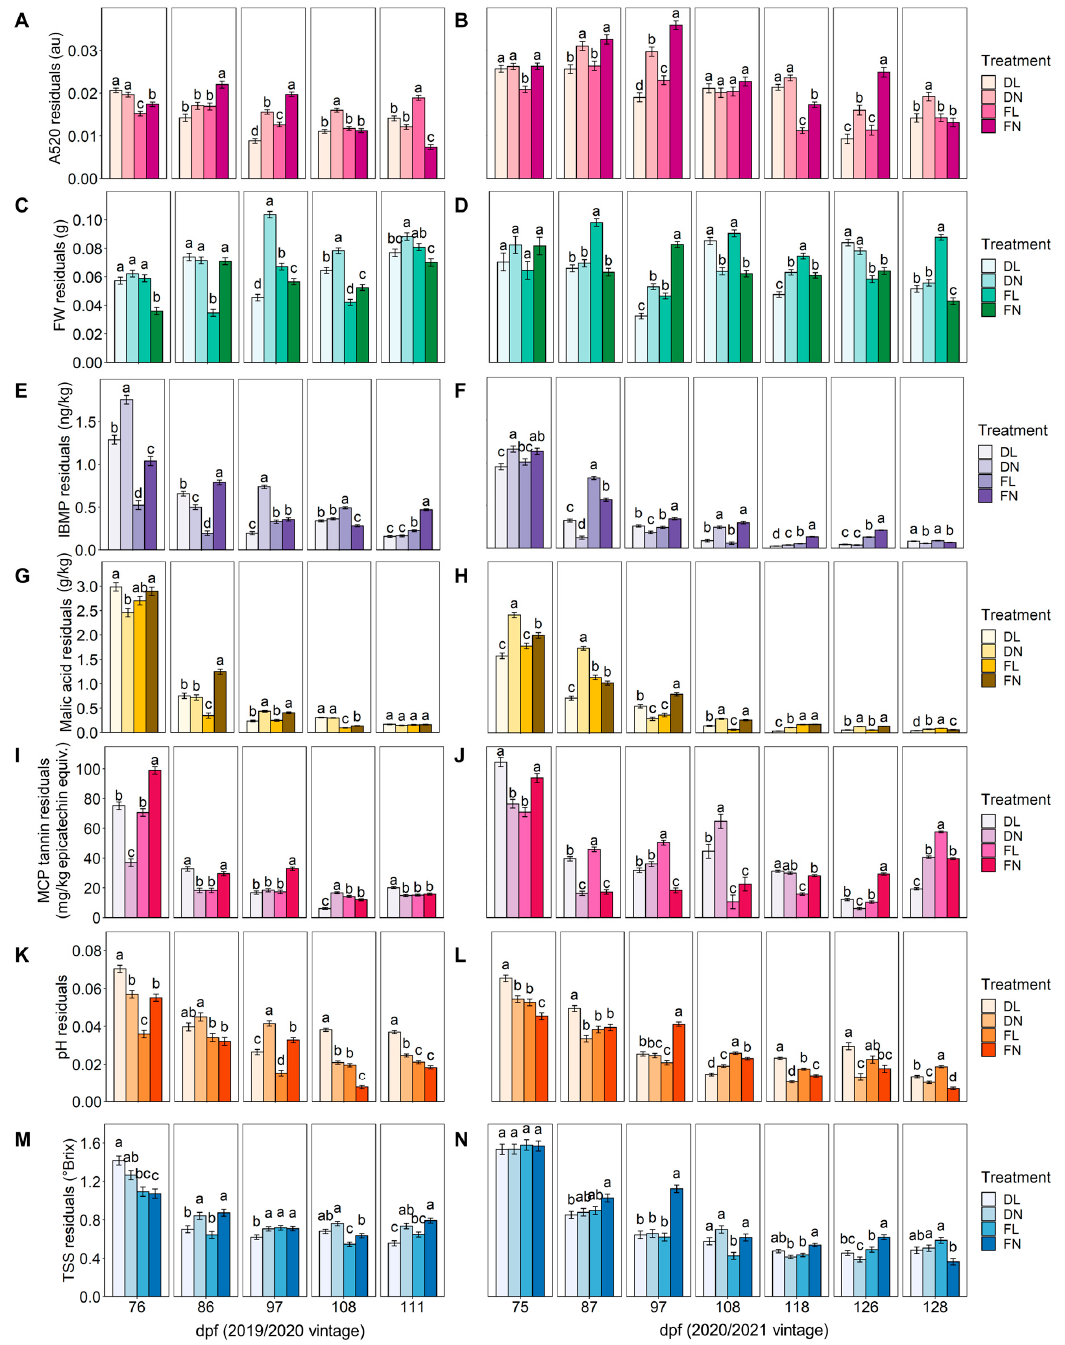
Figure 4. Bar charts showing the changes in the bunch-to-bunch variability (absolute residuals) in response to crop load and irrigation regimes for ( A , B ) absorbance at 520 nm (A520), ( C , D ) berry fresh weight (FW), ( E , F ) 3-isobutyl-2-methoxypyrazine (IBMP), ( G , H ) malic acid, ( I , J ) methyl cellulose precipitable (MCP) tannin, ( K , L ) pH, and ( M , N ) total soluble solids (TSS) for each sampling date (days post-flowering, dpf) in the 2019/2020 ( A , C , E , etc.) and 2020/2021 ( B , D , F , etc.) seasons. Bars and error bars represent the mean ± SEM ( n = 6 vines per treatment). Different lower-case letters on a given sampling date represent significant differences between treatments (linear mixed model, α = 0.05, Bonferroni-adjusted). DL = deficit irrigation/low crop load, DN = deficit irrigation/normal crop load, FL = full irrigation/low crop load, FN = full irrigation/normal crop load (grower control).